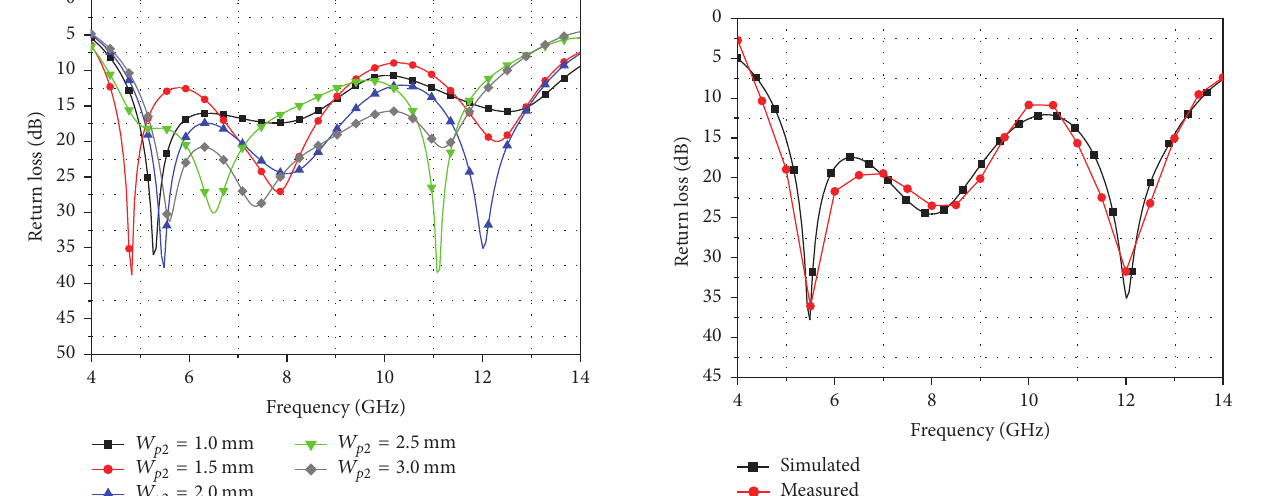
Figure 11: Simulated return loss against frequency for the proposed defected substrate wideband antenna with various 𝑊 𝑝2 ; other parameters are the same as listed in Table 1.